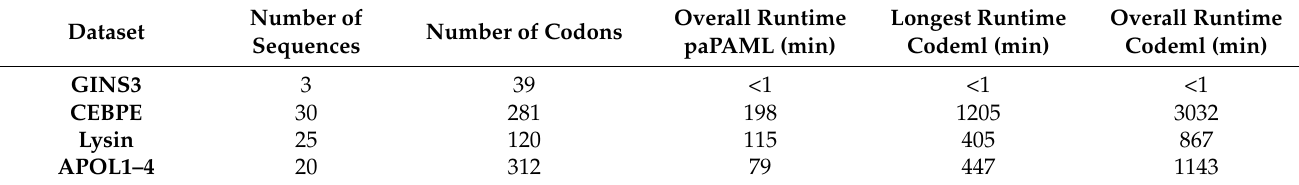
Table 2. Runtime analysis results for example